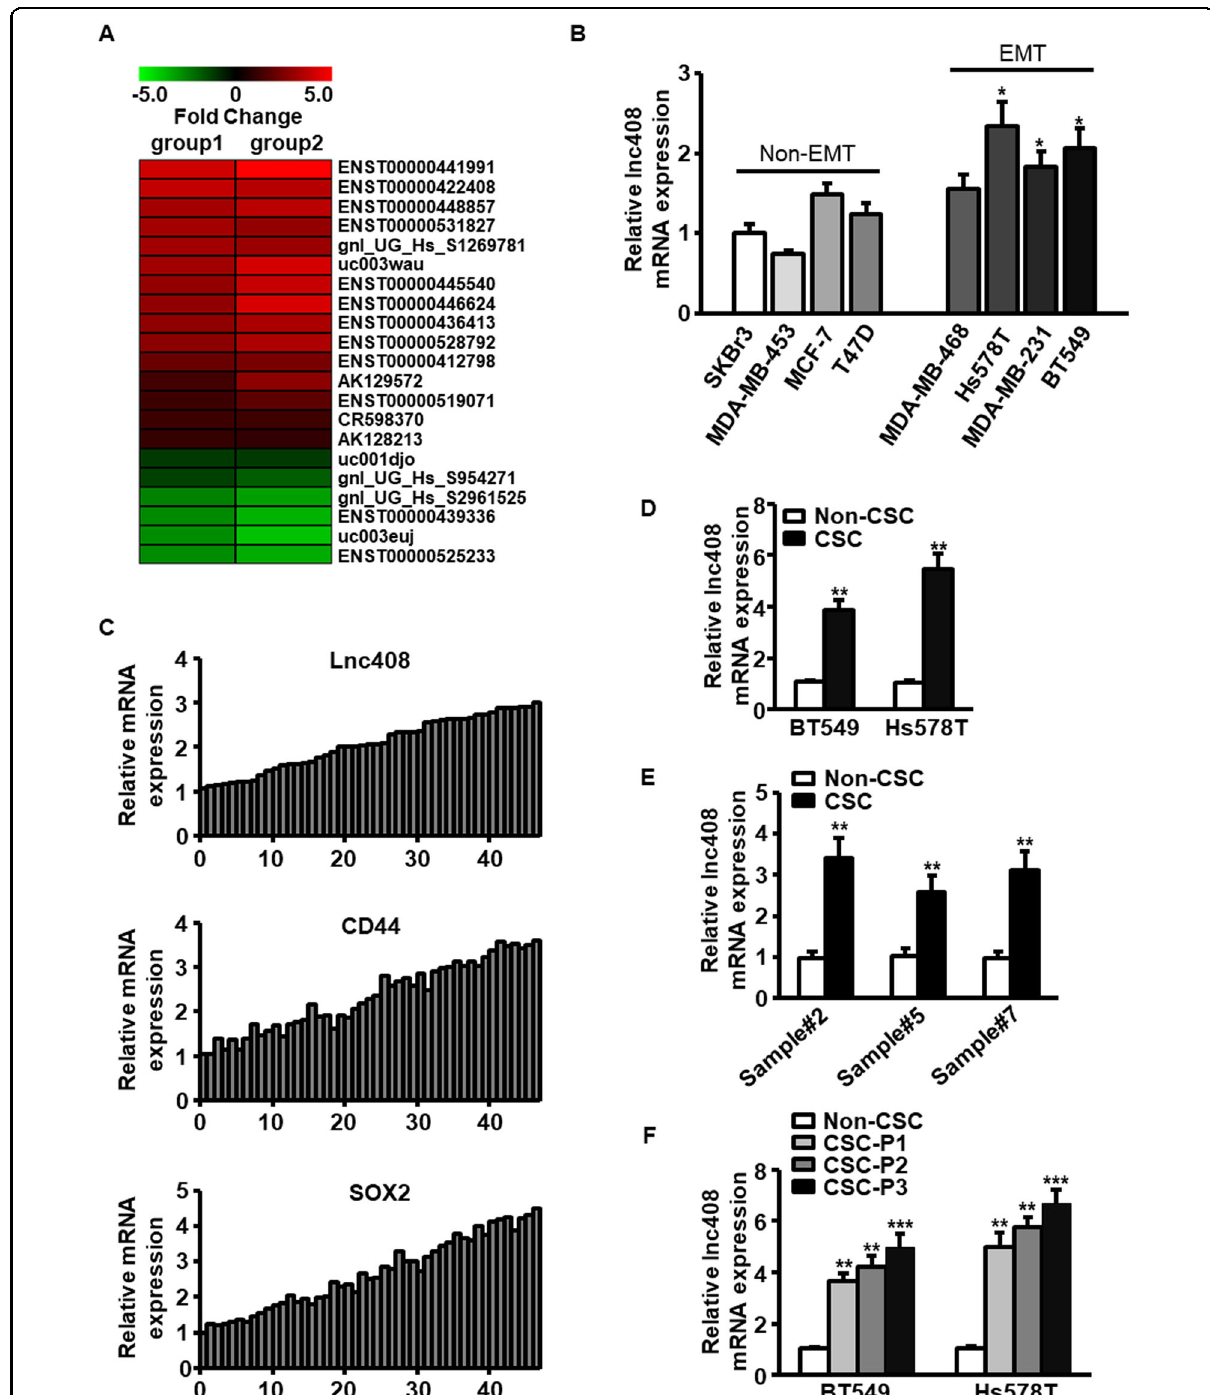
Fig. 1 Lnc408 is upregulated in BCSCs. A The heat map showed the major dysregulated stemness-associated lncRNAs in BCSCs derived from epithelial or mesenchymal MCF-7 cells. The red or green dots indicated upregulated or downregulated lncRNAs, respectively. Data are shown as relative fold changes (>2.0) of MCF-7/Twist vs MCF-7/Vector. B Lnc408 expressions were proved by qRT-PCR analysis in non-EMT and EMT BC cells (SKBr3 as a control group, * P < 0.05). C qRT-PCR was used to assess the expression levels of lnc408, CD44, and SOX2 in BC tissues ( n = 50). D , E qRT- PCR was conducted to determine the abundances of lnc408 in BCSC derived from BC cell lines and clinical BC samples (** P < 0.01). F Lnc408 expression was determined by qRT-PCR in different passage of BCSCs (P1 to P3; ** P < 0.01, *** P < 0.001). For qRT-PCR assays, all data are shown as means ±